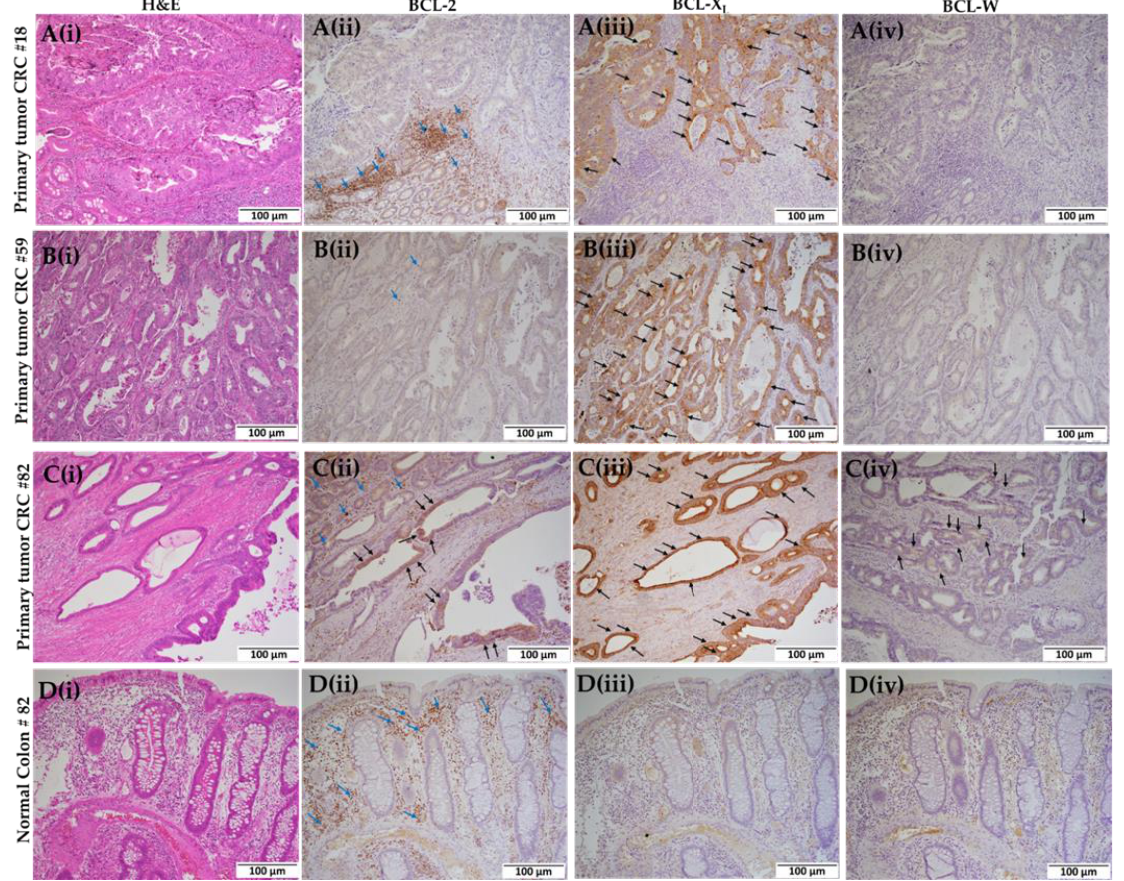
Figure 3. Immunohistochemical detection of BCL-2 family proteins in primary tumors of colorectal cancers (CRC) are shown in panels ( A – C ) and in the matching normal colonic epithelium of case #82 as illustrated in panel ( D ). Panel ( A ) illustrates the staining in tumor tissue of CRC#18. ( A ( i )) Hematoxylin and eosin (H&E) staining, ( A ( ii )) BCL-2, ( A ( iii )) BCL-XL, and ( A ( iv )) BCL-W. Panel ( B ) illustrates the staining in tumor tissue of CRC#59. ( B ( i )) H&E staining, ( B ( ii )) BCL-2, ( B ( iii )) BCL-XL, and ( B ( iv )) BCL-W. Panel ( C ) illustrates the staining in tumor tissue of CRC#82. ( C ( i )) H&E staining, ( C ( ii )) BCL-2, ( C ( iii )) BCL-XL, and ( C ( iv )) BCL-W (patchy weak staining). Panel ( D ) shows the staining of normal colonic epithelium from CRC#82 case. ( D ( i )) H&E staining, ( D ( ii )) BCL-2, ( D ( iii )) BCL-XL, and ( D ( iv )) BCL-W. No immunostaining is noted in normal colonic epithelial cells Panel ( D ( ii – iv )). All images are taken at 10× magnification (scale bar: 100 µm), and arrows (black) indicate positivity of the immunogenic signal in cancer cells. The immunogenic signal in lymphocytes serves as internal positive controls for Bcl-2 staining (blue arrows). Table 1. Clinicopathologic characteristics of CRCs used in the study.